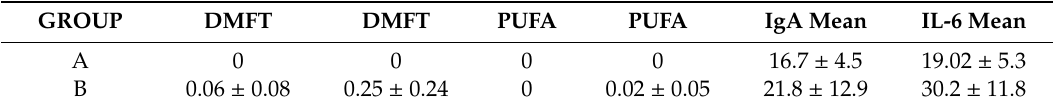
Table 2. A and B groups. Mean values of DMFT, PUFA, salivary immunoglobulin A (s-IgA) (mg / dL), and interleukin 6 (IL-6) (pg / mL).